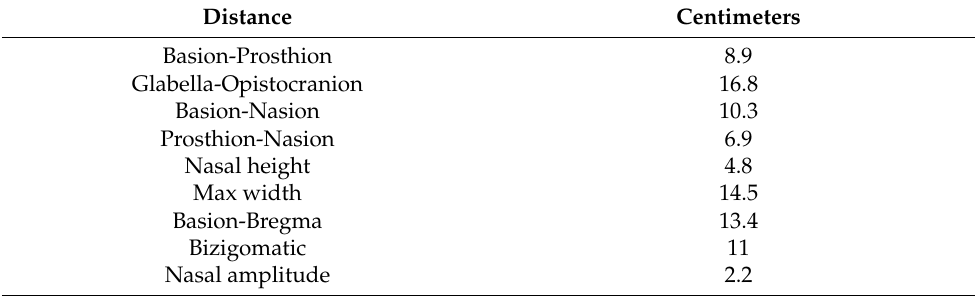
Table 1. Anthropometric measurements of the skeletal